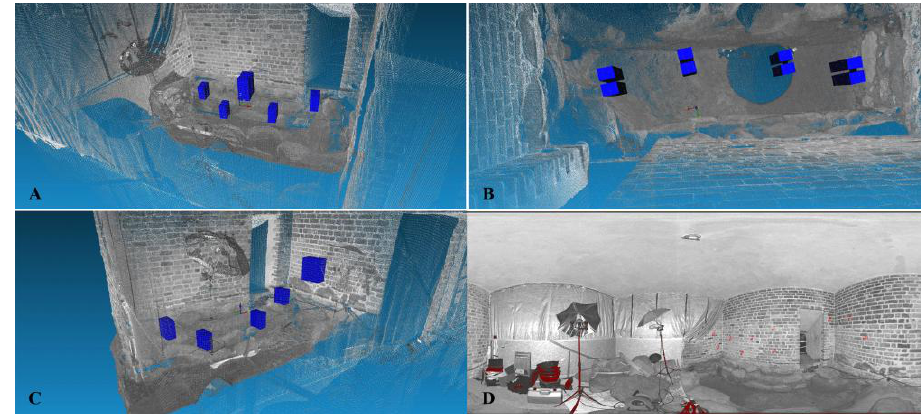
Figure 4. The example locations of scanner stations (A-C) with the control points marked in the spherical image